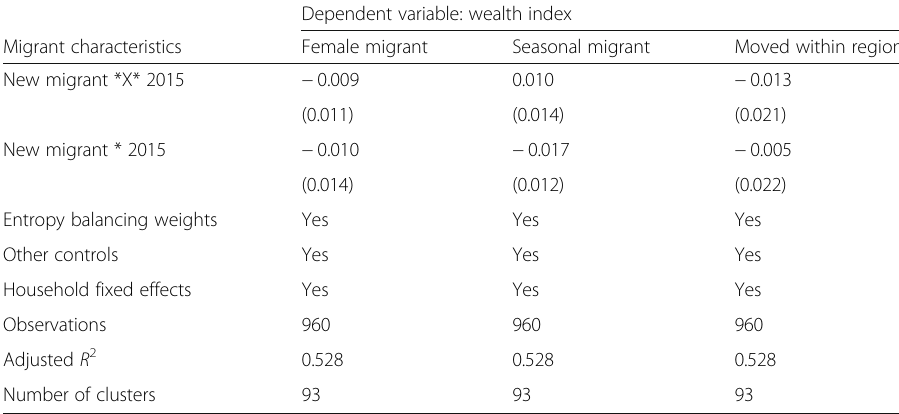
Table 6 Interaction of treatment with the characteristics of new migrants Dependent variable: wealth index Migrant